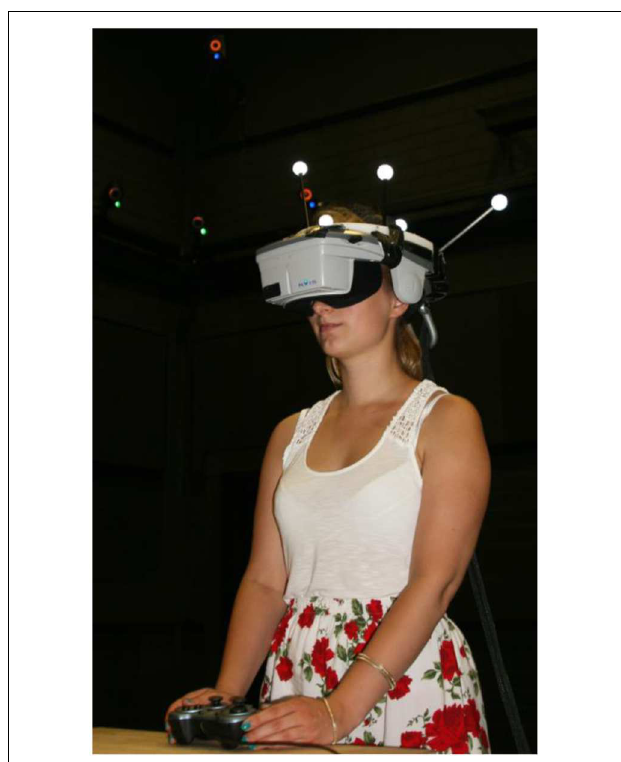
FIGURE 1 | A participant equipped with a head mounted display whose orienation was tracked by motion tracking cameras. Participants used a joystick fixated to a table to adjust their distance estimates.